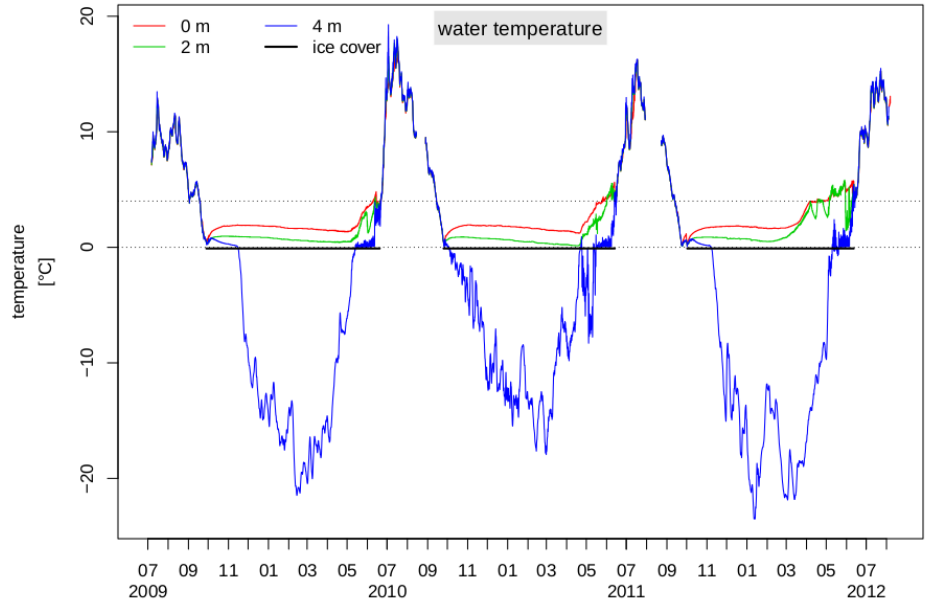
Figure A6. Hourly lake temperatures for Sa_Lake_2, from July 2009 to August 2012. Thick black lines indicate ice-covered periods.